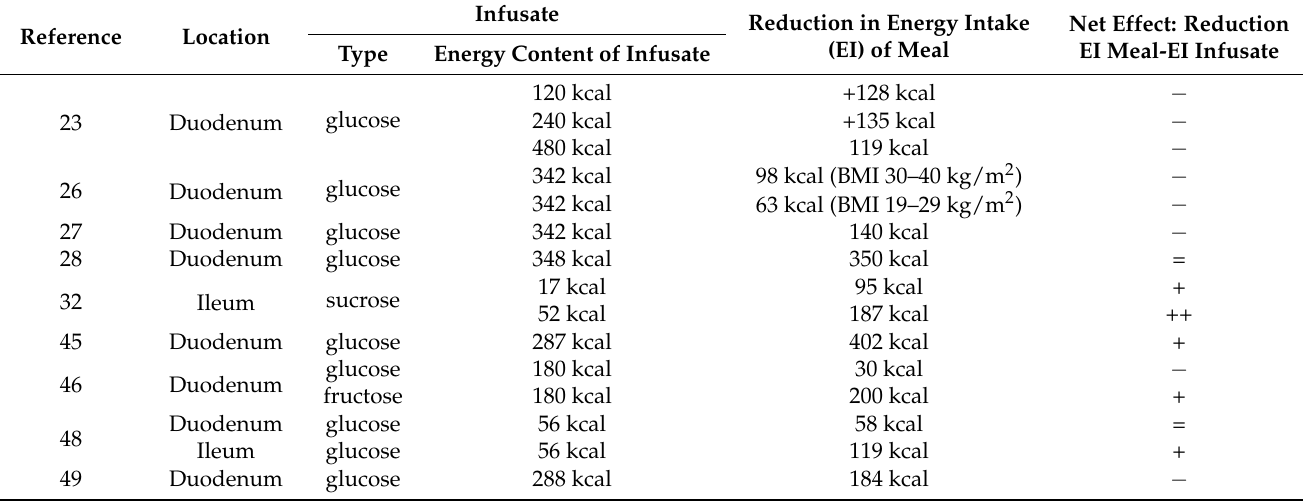
Table A3. Net effect of infusion of carbohydrates into duodenum, jejunum or ileum on energy intake, taking into account the reduction in energy intake of meal minus energy content of the